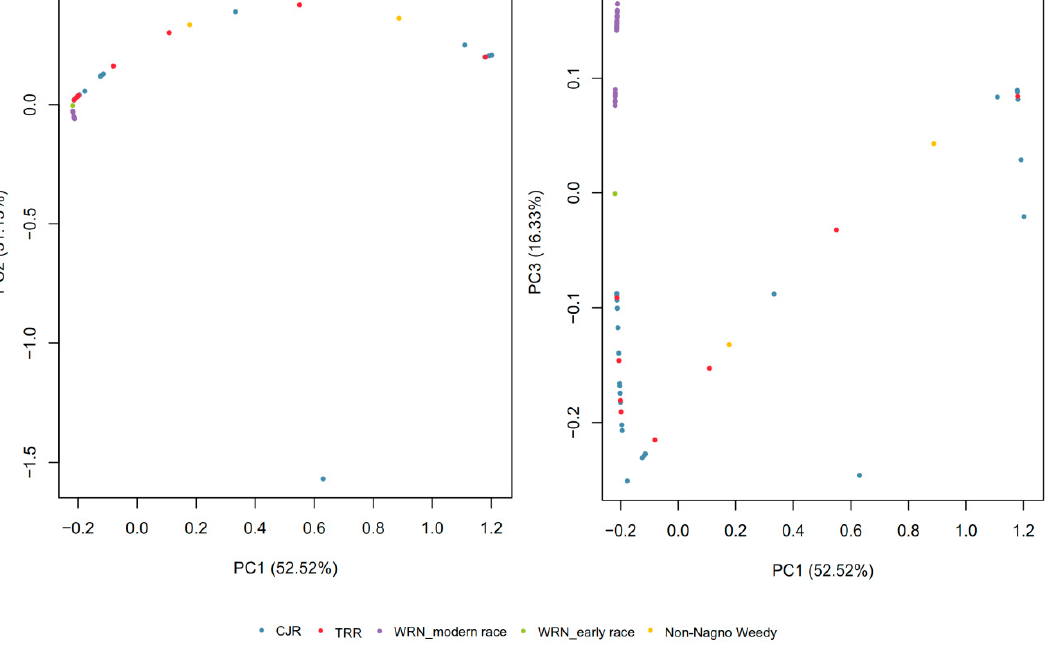
Figure 3. Principal component analysis plots of the first three components of the japonica group. The percentage of genetic variance explained by each principal component are included in the axis labels.